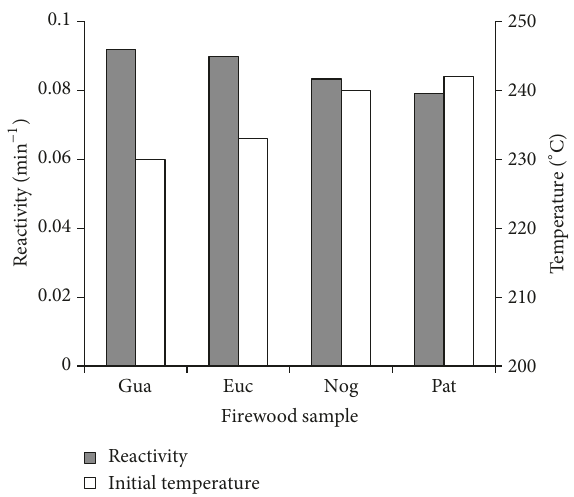
Figure 7: Relative reactivity and initial temperature of